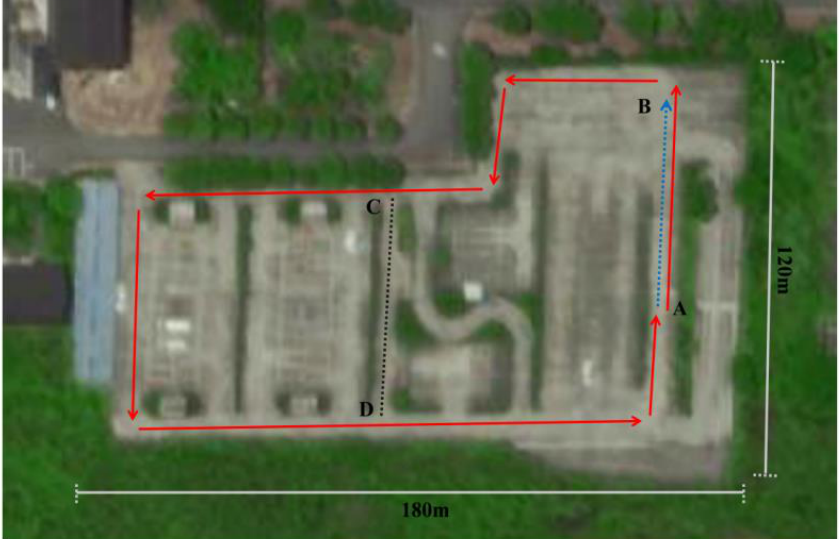
Figure 8. An abandoned driving school at Soochow University. Third scene: Part of the suburb of St Lucia, located in Brisbane, Australia.